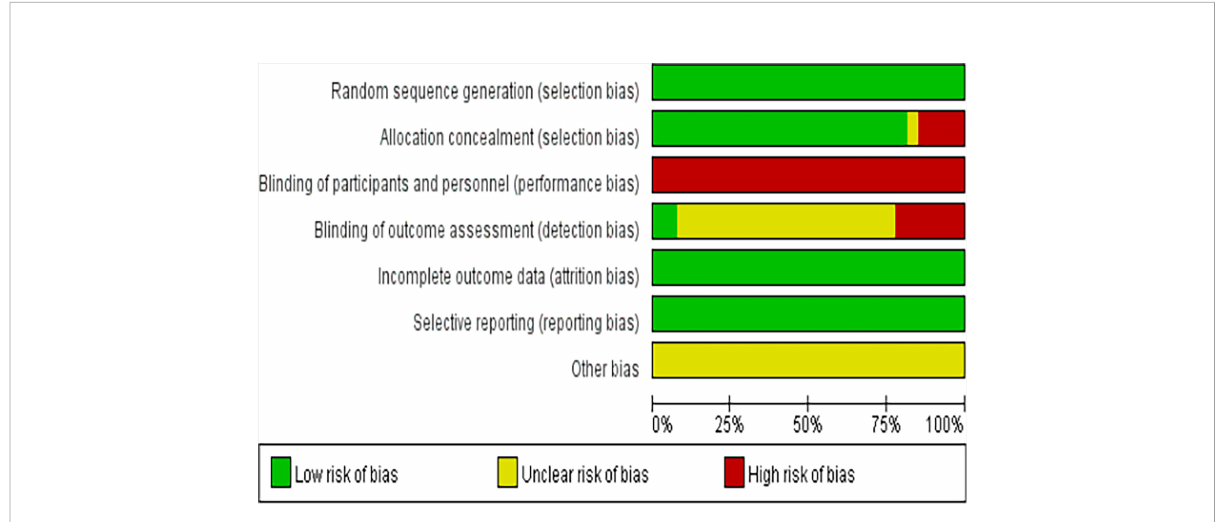
FIGURE 3 Risk of bias assessment graph for included